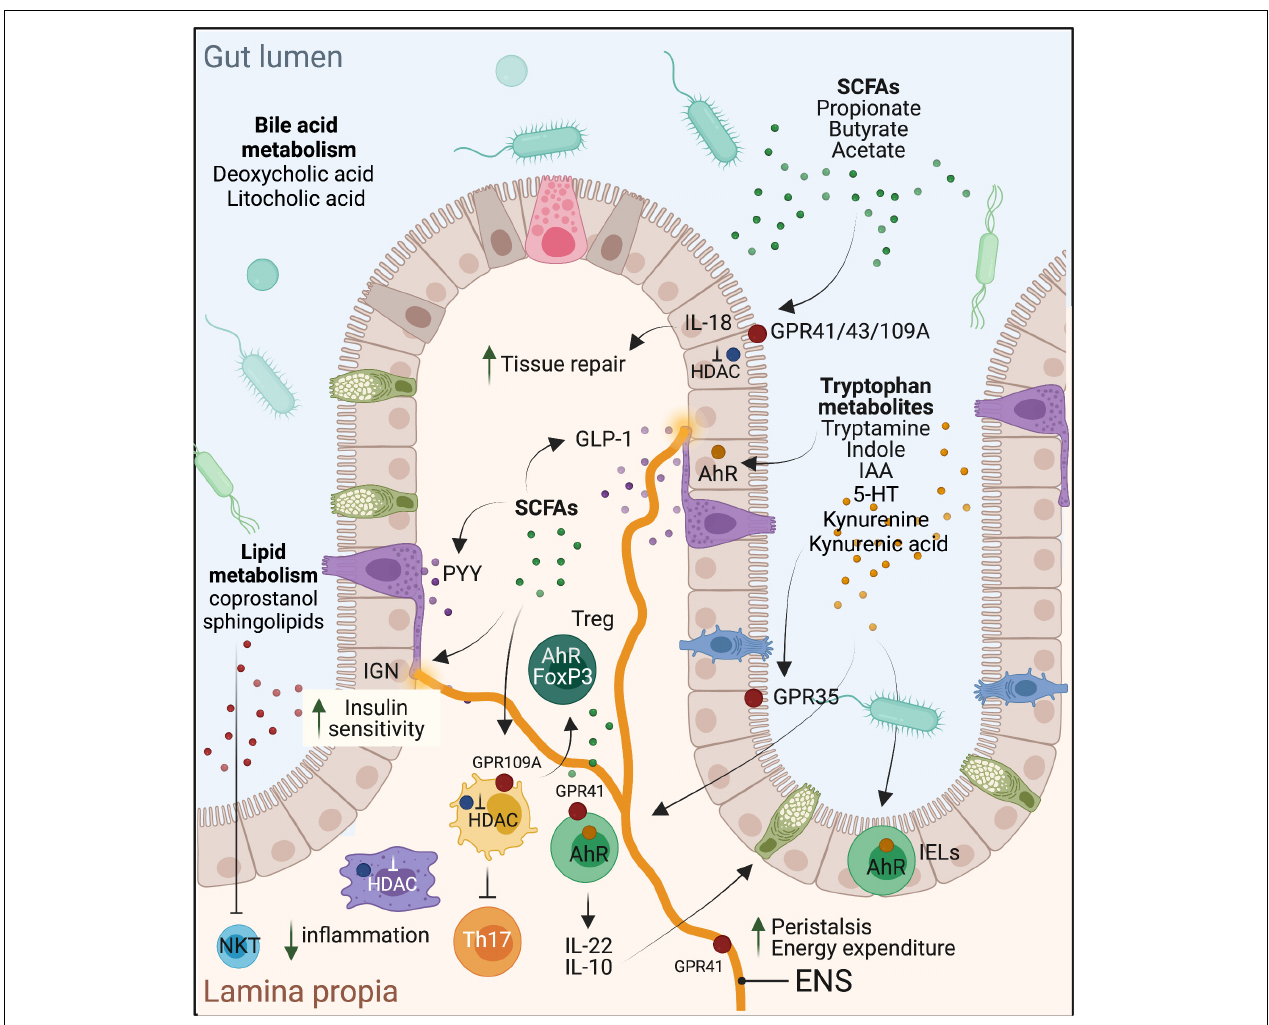
FIGURE 1 | Schematic representation of the effects of select microbial metabolites on intestinal homeostasis, mucosal immune regulation, and metabolic health of the